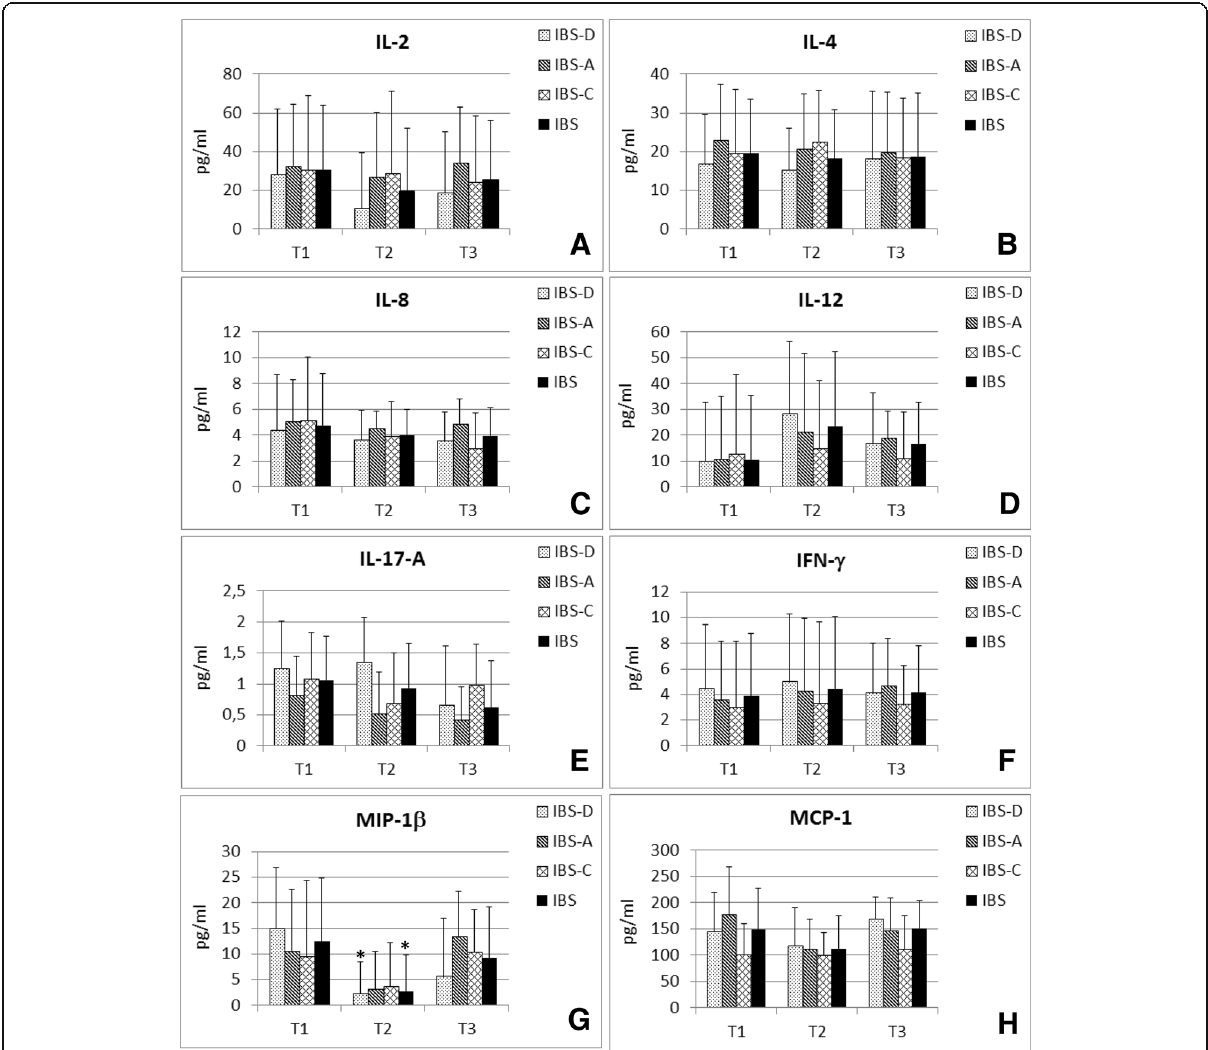
Fig. 3 Plasma cytokine variations measured at T1, T2 and T3. Cytokines were determined using a 13-plex mouse bead immunoassay kit. Levels of IL-2 ( a ), IL-4 ( b ), IL-8 ( c ), IL-12 ( d ), IL-17A ( e ), IFN- γ ( f ), MIP-1 β ( g ) and MCP-1 ( h ) are shown for the whole IBS cohort and for IBS subtypes. Data are expressed as mean±SD of at least three replicates. Calculated P values were corrected for multiple comparisons by using the Benjamini-Hochberg method. * P <0.05 if compared to